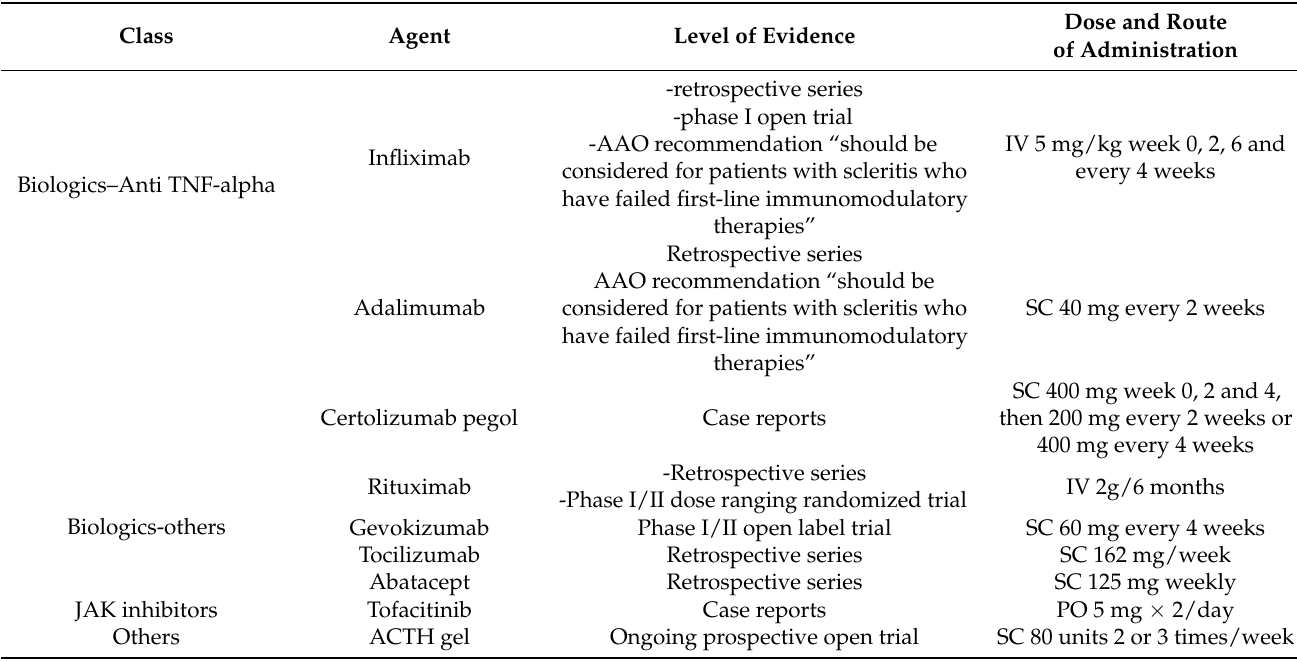
Table 1. New treatment perspectives: agent, level of available evidence, route of administration and dosage. AAO: American Academy of Ophthalmology, ACTH: adrenocorticotropic hormone, IV: intravenous, JAK: Janus Kinase, PO: per os, SC: subcutaneous, TNF: Tumor necrosis